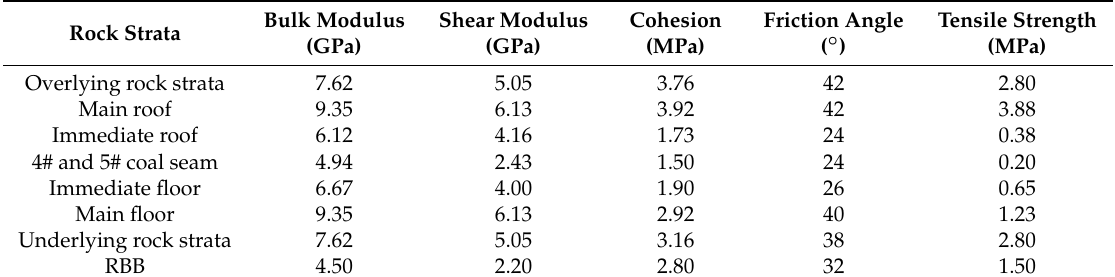
Figure 6. Numerical simulation model. Table 1. Rock mechanics parameters.